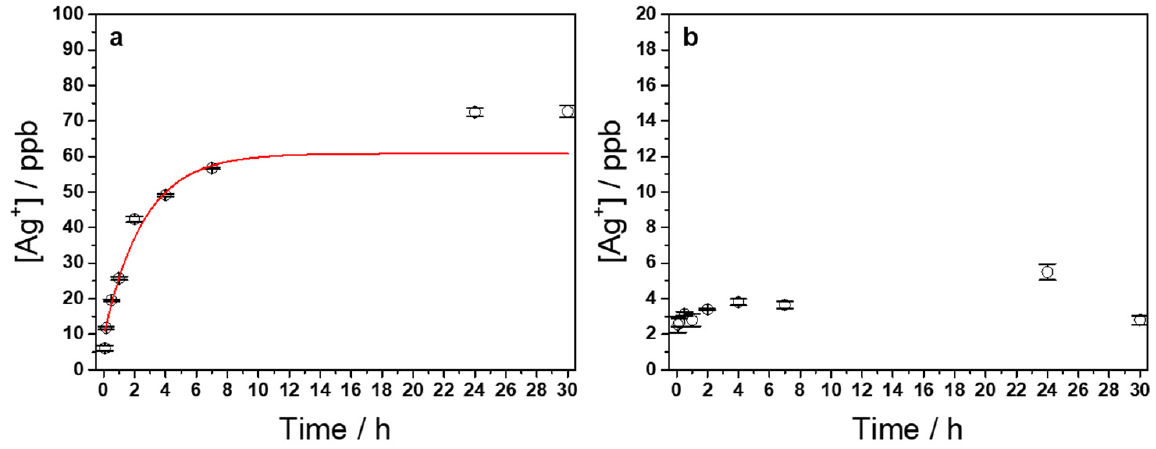
Figure 3. Silver ions release from AgNPs-PHBV composite film in PBS contact solution ( a ); R 2 was equal to 0.9887.